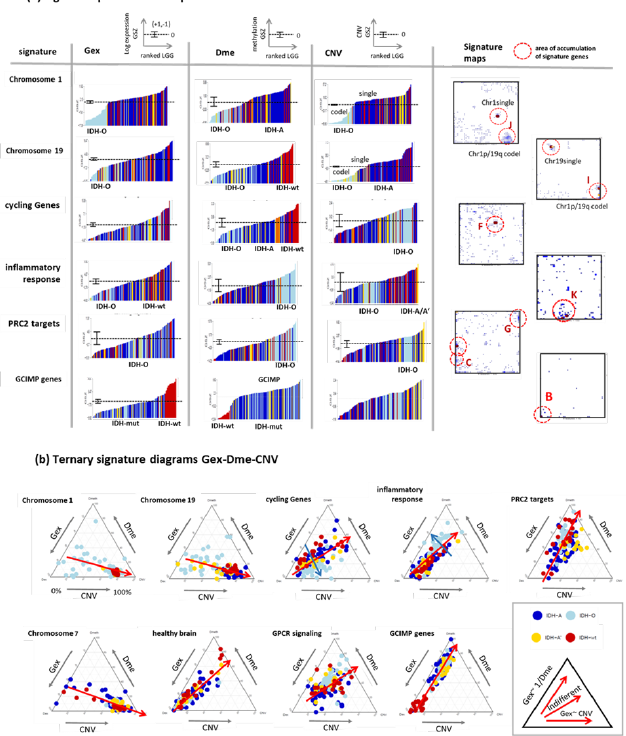
Figure 6. Sets of signature genes were analysed in terms of ranked profiles, maps, and ternary diagrams using the gene set Z score (GSZ) of expression, methylation, and CNV values. ( a ) LGG were ranked with increasing GSZ from left to right. Tumours of different genetic groups accumulate at low or high GSZ values as indicated (LGG-bars are coloured according to their genetic group; see Figure 2 for assignment). The signature maps show the distribution of signature genes in the map. Their accumulation in selected spot areas is indicated by red circles (see Figure 4d). ( b ) Ternary diagrams show mutual dependencies where Gex of the respective set is driven via dose response by CNV (see chromosomal sets), via repression by Dme (see GCIMP set), by combinations of both or none of both (see the legend in the right part). A fine structure spans in direction (blue arrow) perpendicular to the major axis of variation (red arrow). Gene sets were taken from [43,44]. For a larger collection of gene signatures see Figure